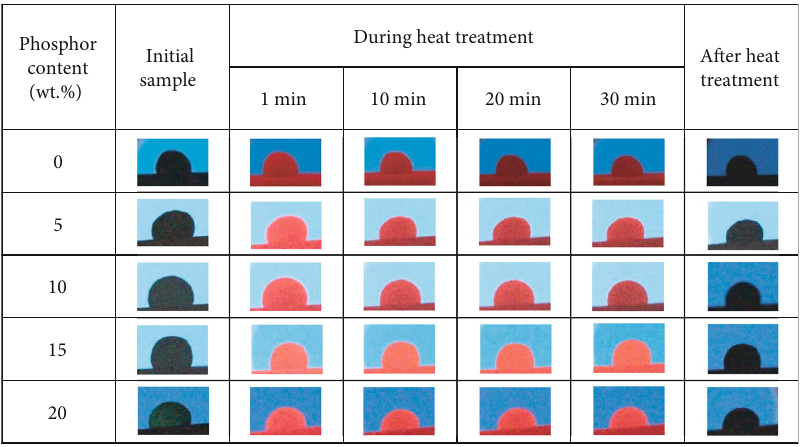
Figure 3: Digital images of samples during the heat treatment at 750 ° C for 30min.